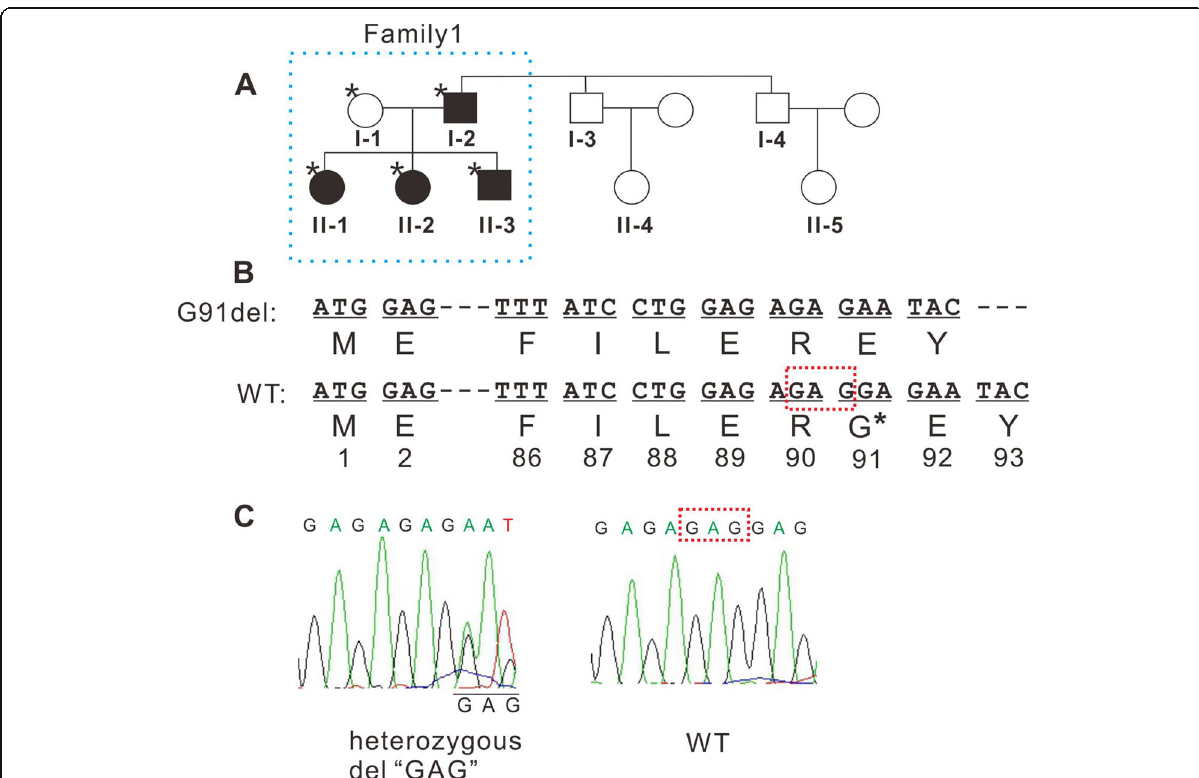
Fig. 1 Overview of CRYBA1 mutation in the family. ( a ) Pedigree of the two-generation family. Filled symbols indicate individuals affected with CC. In individuals marked with an asterisk, the genotype was determined by exome sequencing. ( b ) Diagram of the genetic and amino acid sequences of WT and deleted mutant CRYBA1. The “ GAG ” box is the deleted nucleotide sequence. ( c ) Results of Sanger sequencing of CRYBA1 from affected and unaffected individuals are presented by chromatogram